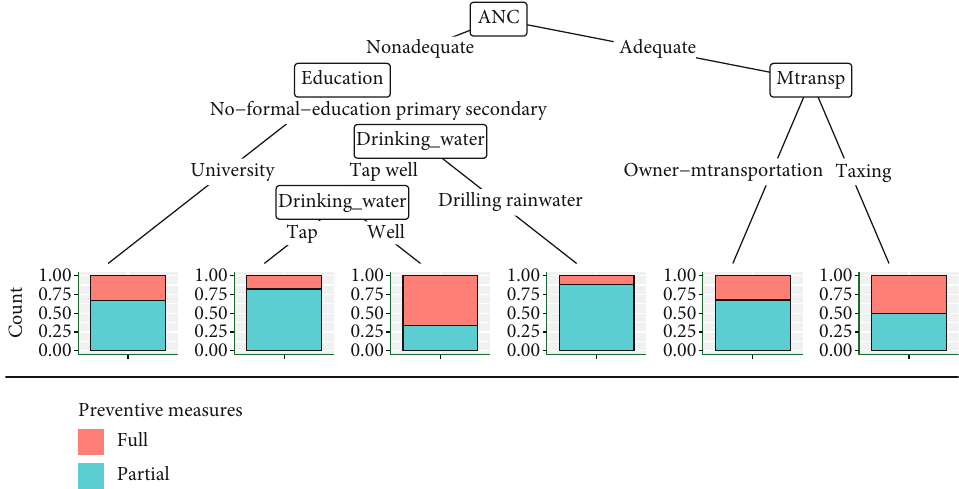
Figure 2: Regression tree of malaria preventive measures and sociodemographic and obstetrical characteristics. Mtransp: means of